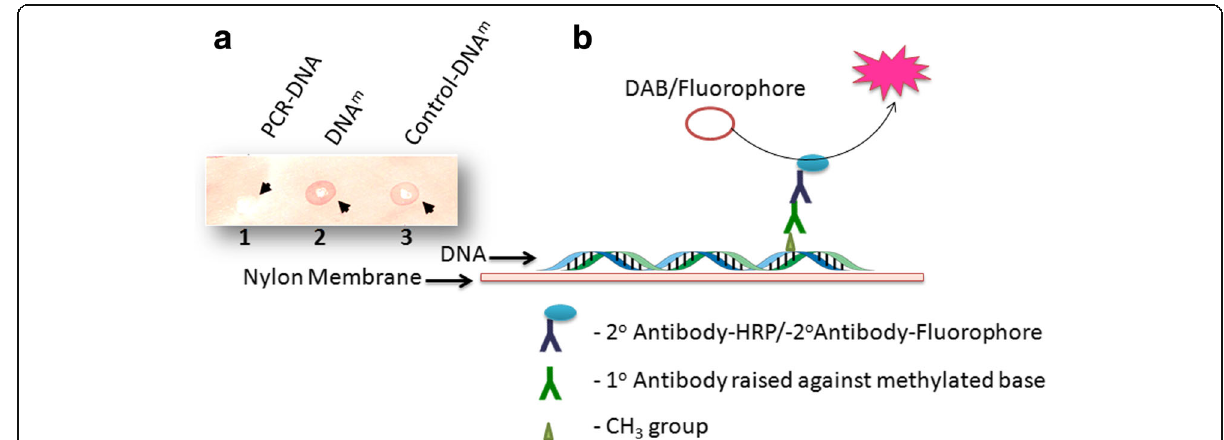
Fig. 3 DNA methylation detection through Immuno-precipitation (Dot-blot method). a. The methylated DNA (dot 2 and 3) develops color precipitate/fluorescence while unmethylated DNA (dot 1) fails to develop the color/fluorescence in the nylon blot. b. The DNA is spotted as a dot in the nylon membrane and then primary antibody is blotted, which is followed by a secondary antibody conjugated with horse radish peroxidase enzyme. The addition of enzyme ’ s substrate such as 3 ’ -3 ’ diamino benzidine (DAB) produces a pink precipitate. Alternatively, a fluorophore-tagged secondary antibody (Alexa Fluor Ab) can be used to visualize the presence of methyl